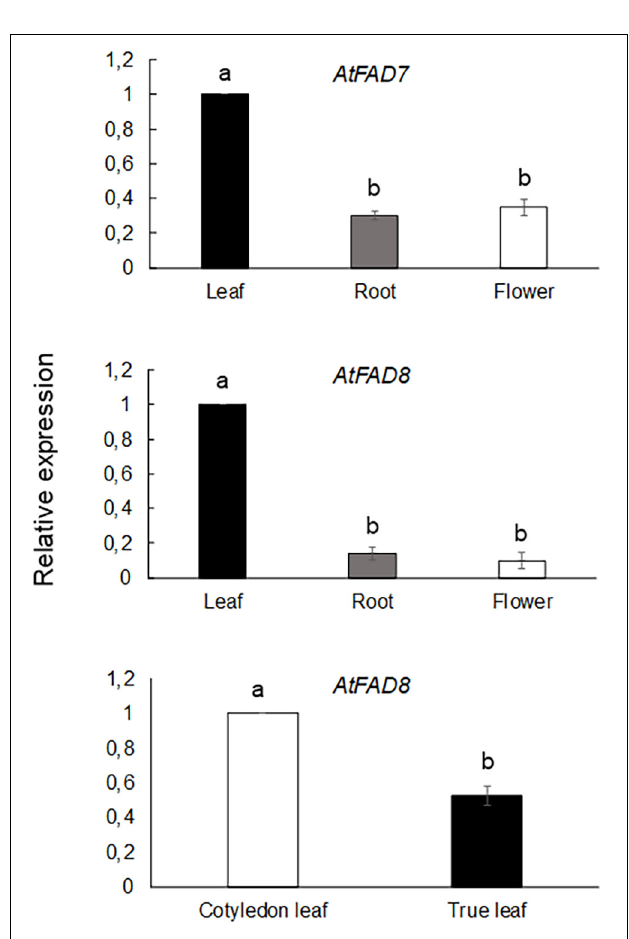
FIGURE 2 | qPCR analysis of AtFAD7 and AtFAD8 gene expression in leaves, roots or flowers from Col-0 Arabidopsis plants grown at 22 ◦ C. AtFAD8 gene expression from cotyledonal and true leaves from 2-week old rosette leaves is also shown in the lower panel. Data represent means from at least three biological replicates. Different letters indicate significant differences among treatments ( P <